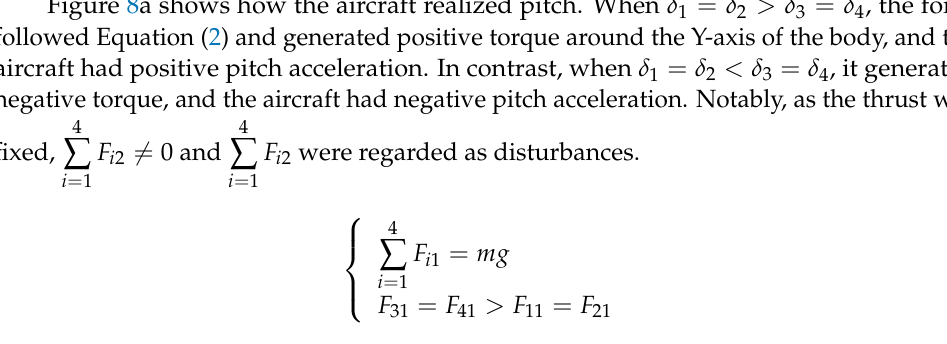
Figure 8. Attitude control schematic: ( a ) nozzles motion to produce pitch angular accelera- tion; ( b ) nozzles motion to produce roll angular acceleration; ( c ) nozzles motion to produce yaw angular